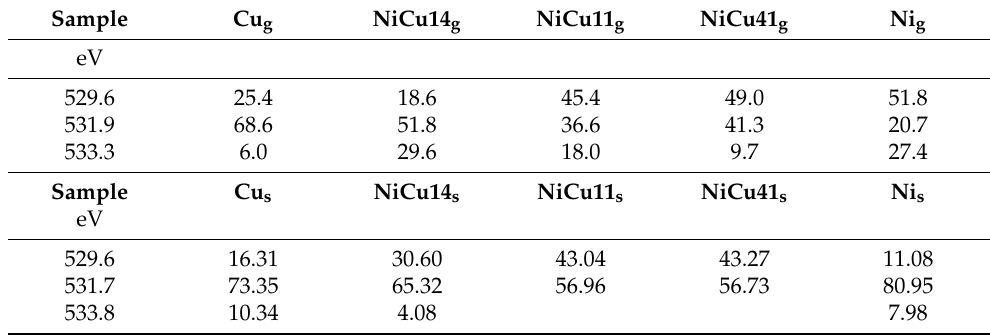
Table 6. Fractions of different oxygen species on the surface (%) according to O1s peaks after decon- volution.